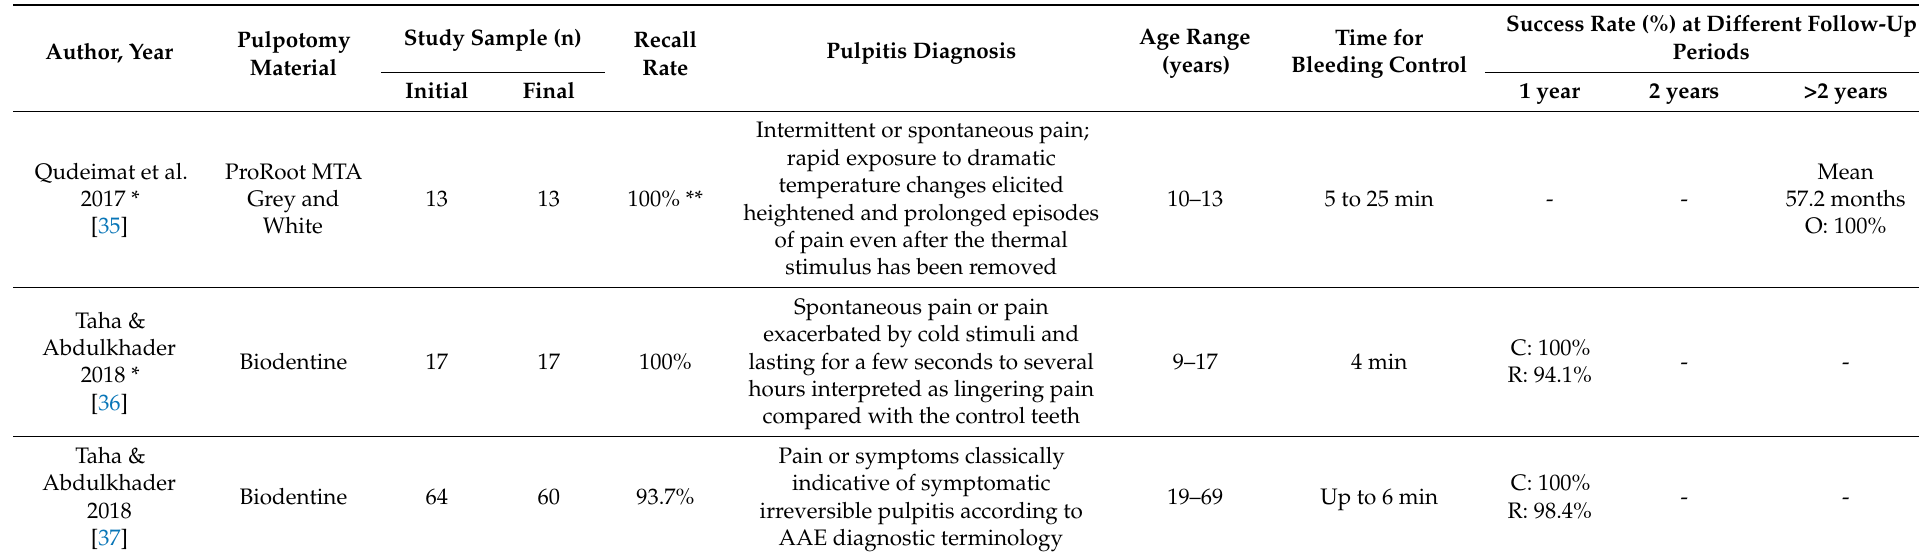
Table 4. Characteristics of included prospective cohort studies of full pulpotomy